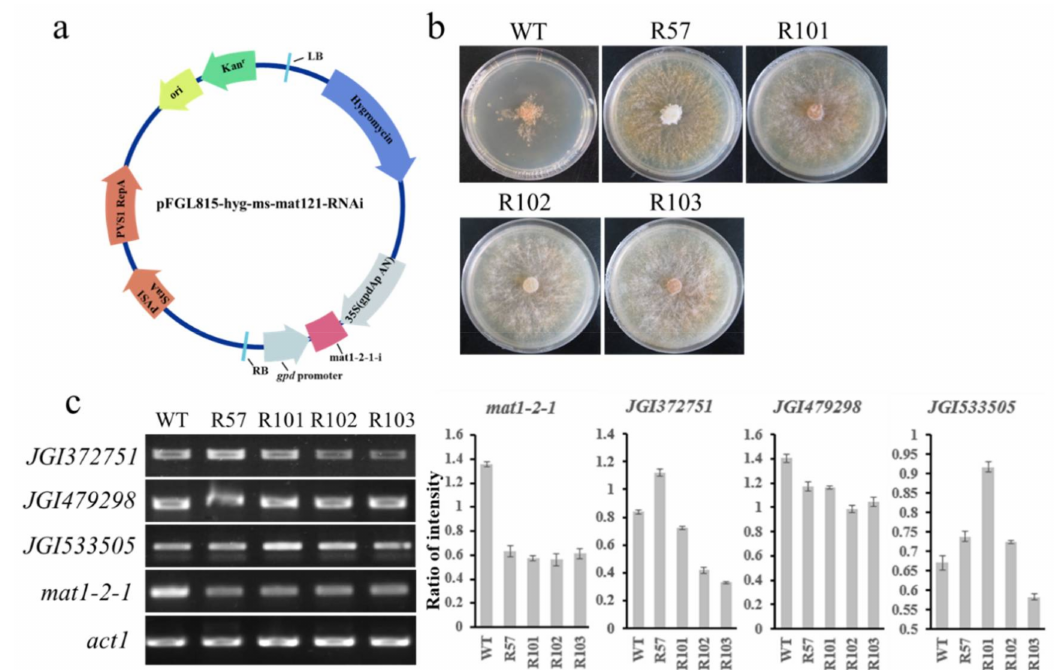
Figure 7. Phenotype of the MAT1-2 strain after the silencing of mat1-2-1 by RNA interference. ( a ) The construction of plasmids pFGL815-hyg-ms-mat121-RNAi. ( b ) Wildtype strain and transformants after 7 days of cultivation on PDA supplemented with 10 µ g/mL hygromycin B. ( c ) The expression levels of mat1-2-1 and its target genes in different transformants on PDA. Constitutive act1 served as the control. Intensity ratio indicates gene expression versus act1 expression; error bars indicate standard